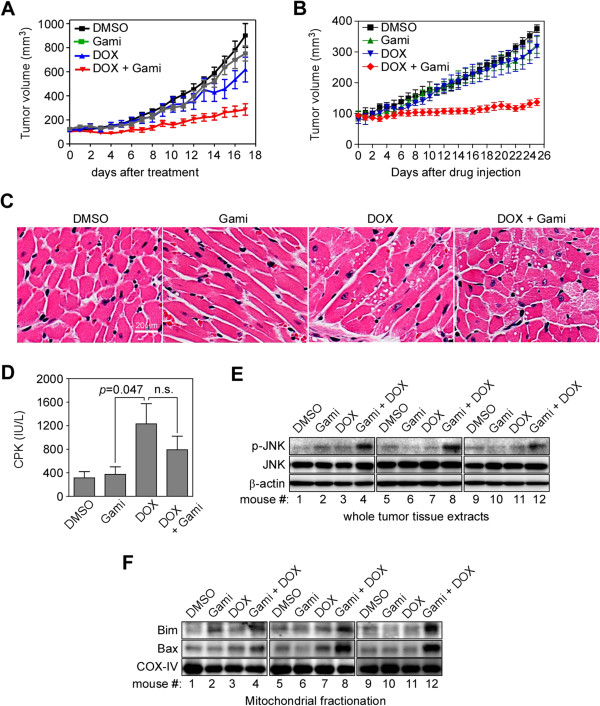
Drug combination effect in vivo. (A) Prostate cancer xenograft. 22Rv1 cells (7 × 106 cells) were injected subcutaneously into both flanks of nude mouse (5 mice/group). After tumors were established, mice were treated twice a week with 3 mg/kg DOX i.v. and 10 mg/kg gamitrinib i.p. as single agents or in combination. (B) Orthotopic xenograft of breast cancer cells. MDA-MB-231 cells (1 × 107 cells) were grown in mammary fat pads of nude mouse (3 mice/group). Mice were treated twice a week with 3 mg/kg DOX i.v. and 10 mg/Kg gamitrinib i.p. as single agents or in combination. (C) Hematoxylin and eosin staining of heart tissues. At the end of the experiment in (B), heart ventricles were collected from the mice and analyzed by hematoxylin and eosin staining. Magnification, 200×. (D) Serum creatine phosphokinase activity. Blood was drawn from mice at the end of experiments in (B) and serum creatine phosphokinase (CPK) activity was measured. n.s., p > 0.05. (E) JNK phosphorylation in tumor tissue. Tumor samples collected from the xenograft mice in (B) were analyzed by western blotting. (F) Accumulation of Bim and Bax in mitochondria. Mitochondrial fractionations isolated from the tumors in (B) were analyzed by western blotting.